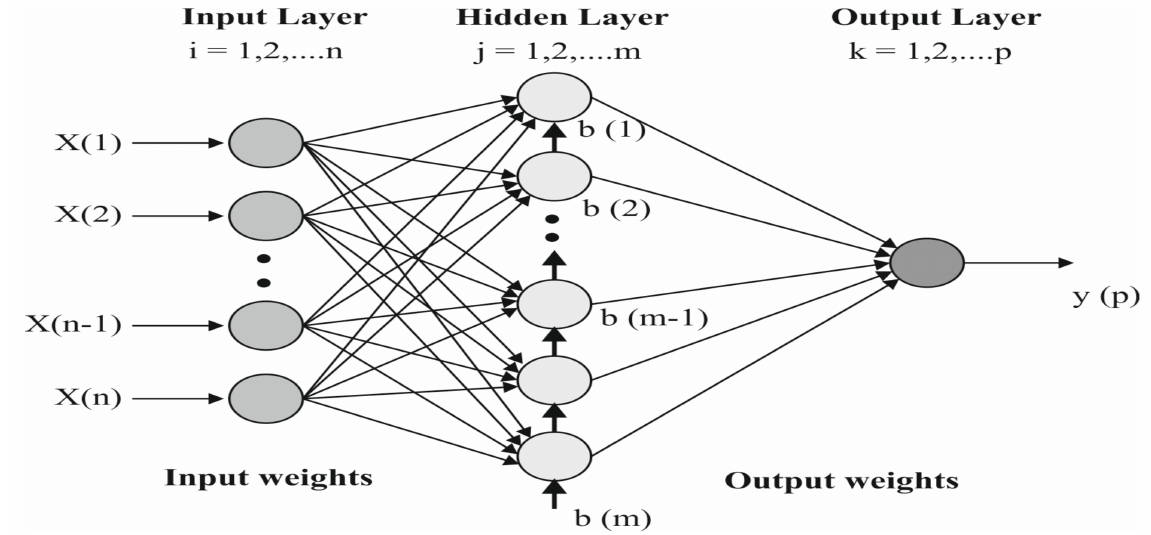
Figure 4. Structure of